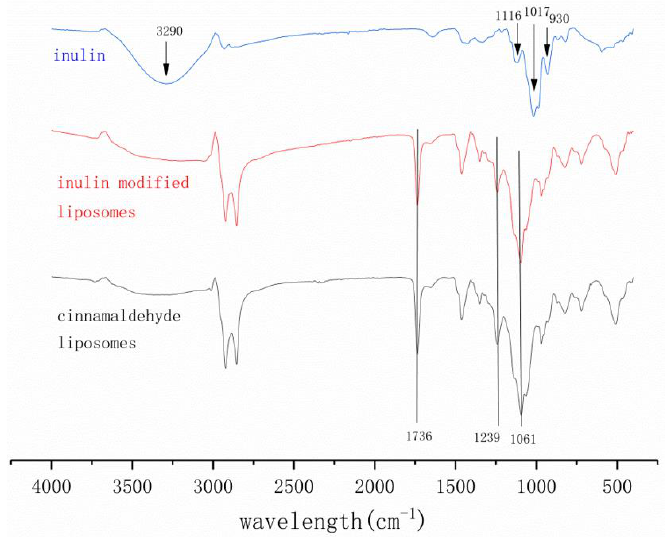
Figure 3. Fourier transform infrared (FTIR) spectra of inulin, inulin modified liposomes and cin- namaldehyde liposomes.